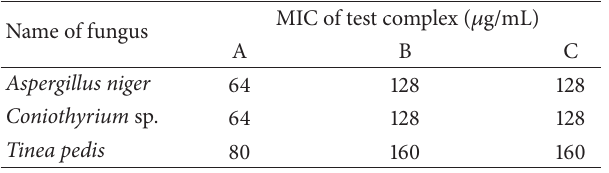
Table 12: Effect of test compounds on total protein in peritoneal fluid.